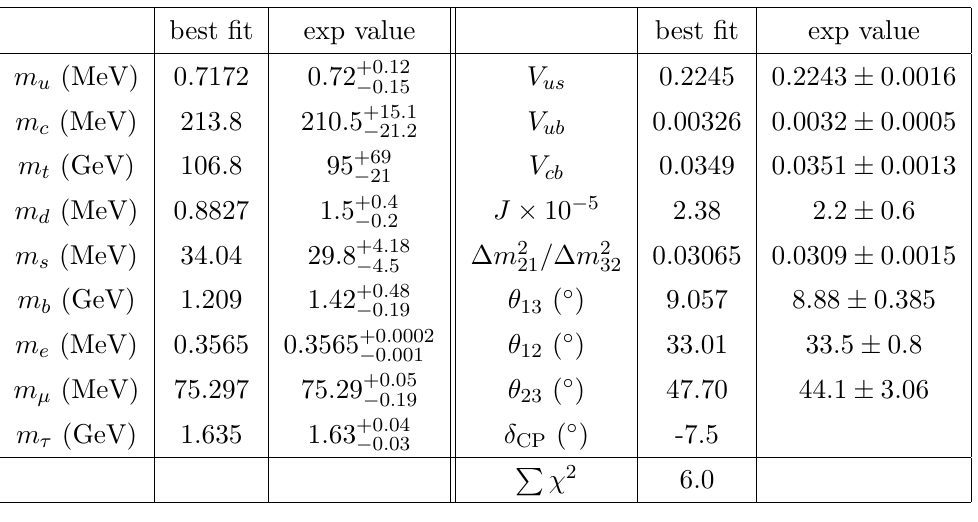
Table 6 . Fit values for the GUT-scale charged fermion masses, solar-to-atmospheric mass squared ratio, and CKM and PMNS mixing parameters for a sample (cid:12)t with Type-II seesaw. The 1 (cid:27) experi- mental values are also shown for comparison [81, 90], where masses and mixings are extrapolated to the GUT scale using the MSSM renormalization group equations (RGEs). Note that the (cid:12)t values for the bottom quark mass and the CKM mixing parameters involving the third generation shown here include the SUSY-threshold